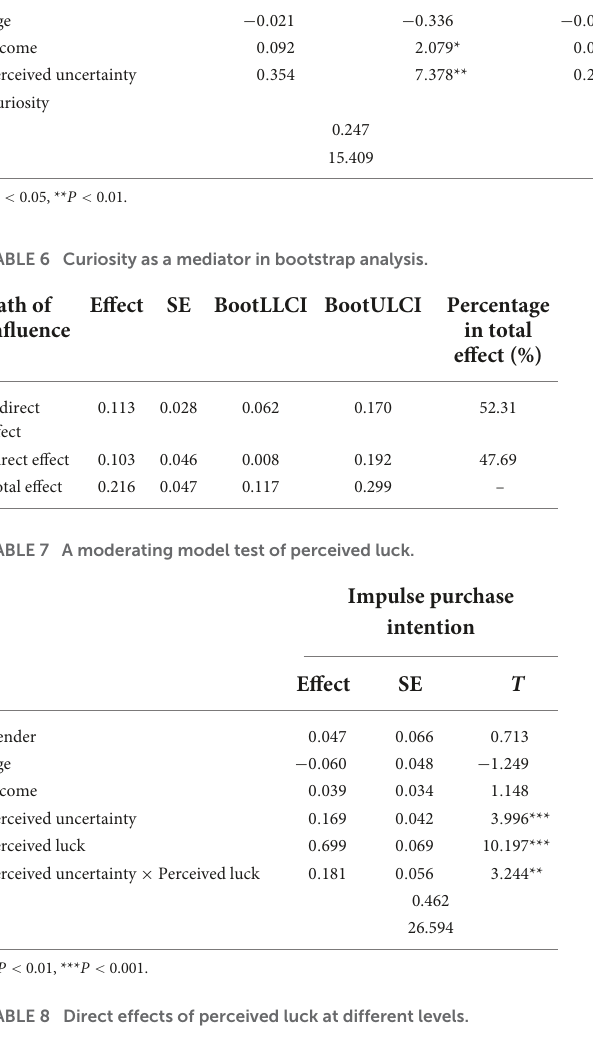
TABLE 8 Direct effects of perceived luck at different